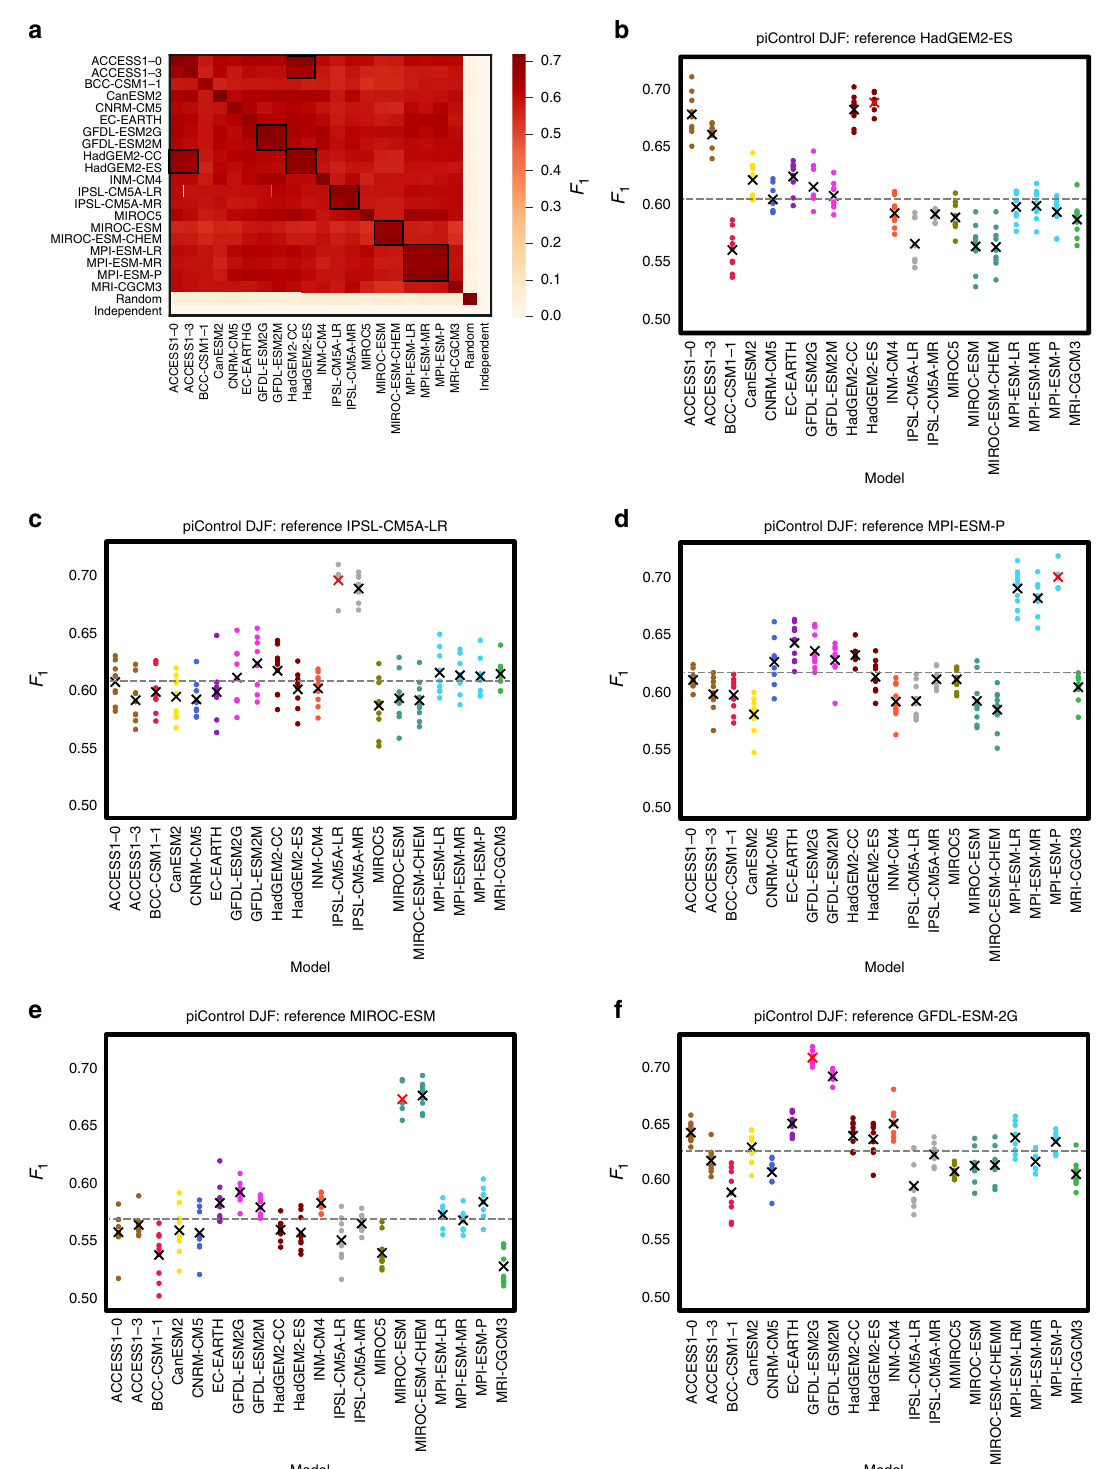
Fig. 2 Pre-industrial network intercomparison scores. a Matrix of average F 1 -scores for pair-wise network comparisons between ensemble members of 20 climate models (labelled following CMIP5 nomenclature in capital letters) using data for December – January – February (DJF) and the two surrogate models (Random, Independent). Rows are models taken as reference in each case, columns are the models that are compared to these references. Higher scores imply better agreement between networks, i.e., that two models are more similar in terms of their causal fi ngerprint. b – f Scatter plots showing each individual network comparison score, with different models taken as reference (as labelled in the sub- fi gure titles) that the other models (labelled on the x -axis using capital letters) are compared to. Black crosses (red for the reference) mark average results also shown in ( a ). Grey dashed lines mark the average score excluding the reference itself. Our causal model evaluation approach detects the expected similarities between certain model groups as shown in ( b – f ), which are additionally indicated by inset black squares in ( a ). Source data are provided as a Source Data fi